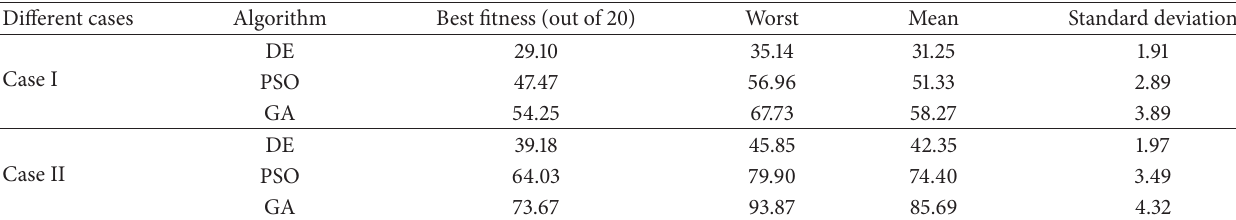
Table 5: Comparative performance of DE, PSO, and GA.